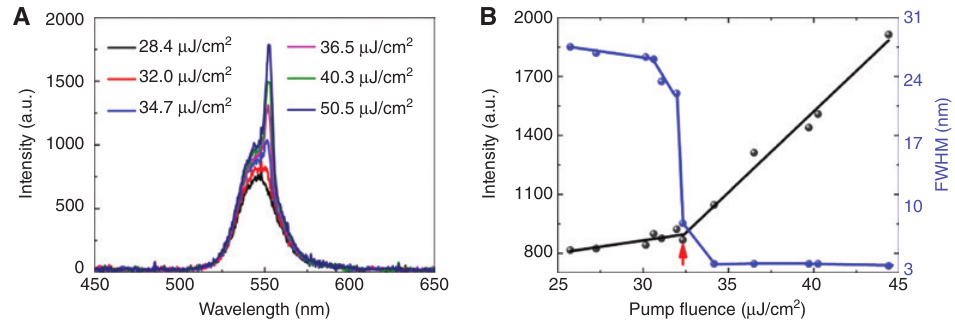
Figure 3: Measured emission properties of the proposed laser device. (A) Emission spectra of the perovskite random laser on the fiber facet measured at different pump fluences. The center wavelength is 552 nm. (B) FWHM and output intensity of the perovskite random laser as a function of the pump fluence, indicating the threshold of 32.3 μ J/cm 2 .